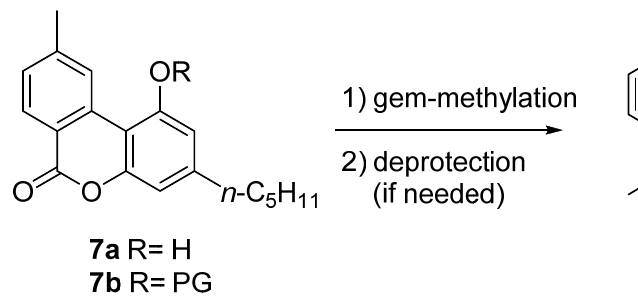
Figure 3. The structure of lactone intermediate 7a – b.